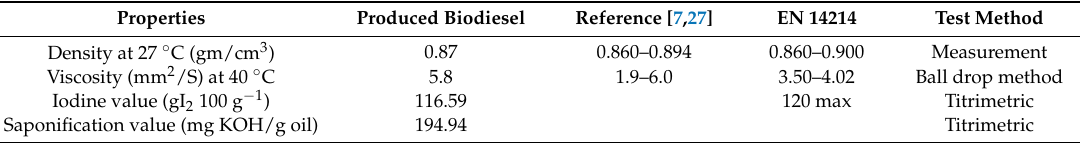
Table 8. Properties of synthesized biodiesel from waste cooking oil and comparison with biodiesel standard.